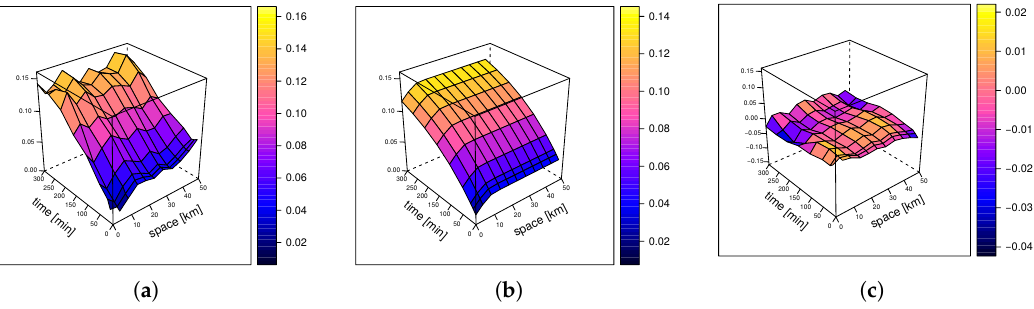
Figure 7. Spatio-temporal variograms. ( a ) empirical (sample) variogram; ( b ) theoretical sum-metric model; ( c ) difference between sample and best fitting theoretical sum-metric model.